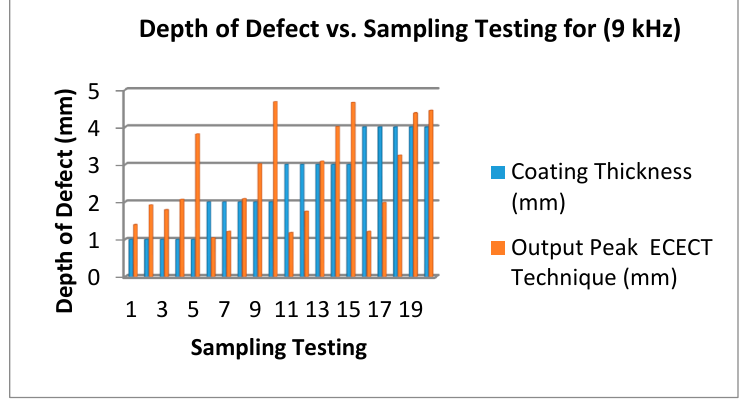
Figure 16. Depth of Defect (mm) vs. Testing Sampling (9 kHz Frequency).